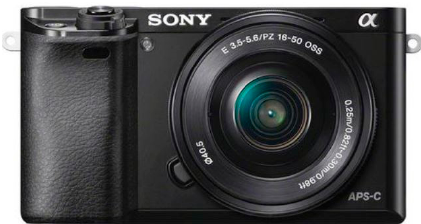
( b ) Figure 3. The fixed-wing UAV used in this study. ( a ) Tuffwing fixed-wing UAV. ( b ) The UAV in the take-off position. Table 2. Specifications of the fixed-wing unmanned aerial vehicle (UAV) platform. Items